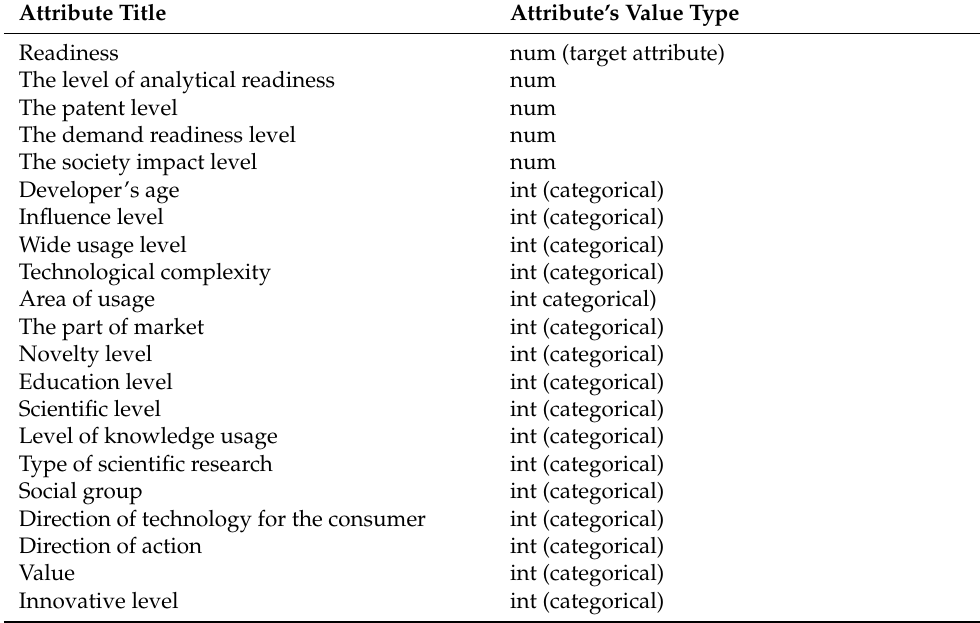
Table 1. Dataset